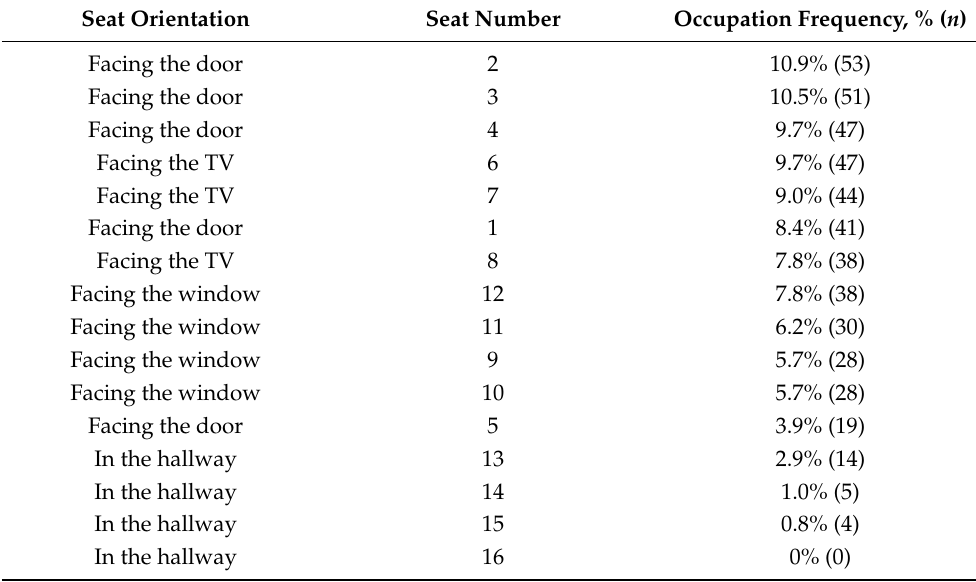
Table 5. Chair occupancy in morning and afternoon clinics.